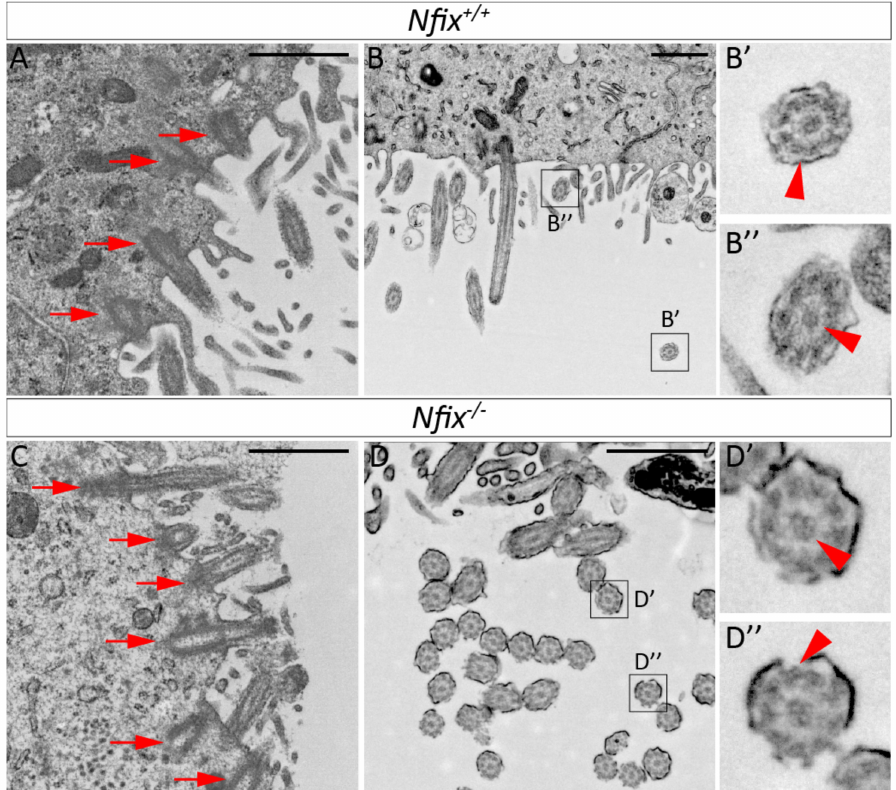
Figure 3. TEM of Nfix − / − ependymal cells reveal abnormal cilia structure. ( A , C ) High magnification images of Nfix +/+ ( A ) and Nfix − / − ( C ) ependymal cilia anchors depicted by red arrows. No visual differences in cilia anchor structure or protein density could be identified. ( B , D ) Images contain- ing ependymal cilia cross sections from P5 Nfix +/+ ( B ) and Nfix − / − ( D ) mouse lateral ventricles. ( B’ , B” ) Nfix +/+ ependymal cilia cross sections show the 9 + 2 motile cilia structure with 9 pairs ( B’ , red arrowhead) of microtubules around the outside and 2 ( B” , red arrowhead) in the centre. ( D’ , D” ) P5 Nfix − / − ependymal cells demonstrated structural differences which deviated from the traditional 9 +2 structure including the presence of additional microtubules in the centre ( D’ , red arrowheads) and/or the presence of microtubule triplets around the outer edge ( D” red arrowhead). Every cilia cross section examined in P5 Nfix − / − ependymal cells had one or more additional microtubules present along the outer edge or the centre. Scale bars ( A – D ) represents 1 µ